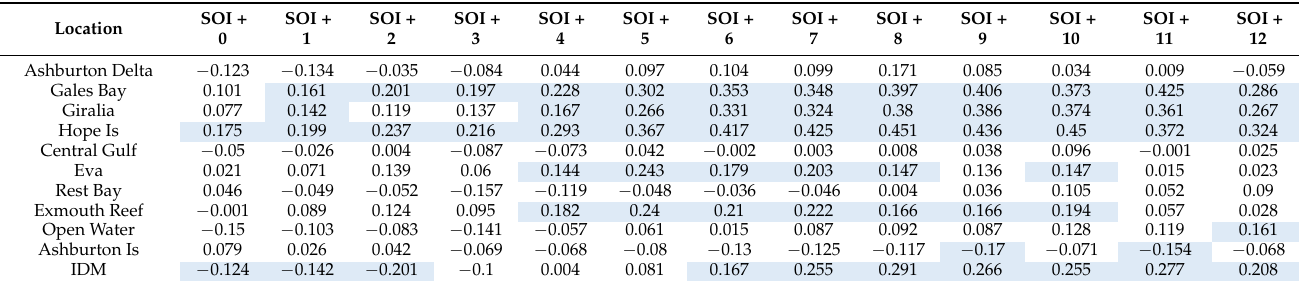
Table A2. Pearson’s r correlations between turbidity and the El-Niño Southern Oscillation Index (SOI) at different time lags. Highlighted cells indicate significant correlations ( p < 0.05). Additionally included is the correlation between SOI and the Indian Dipole Mode (IDM) at the same lag increments.